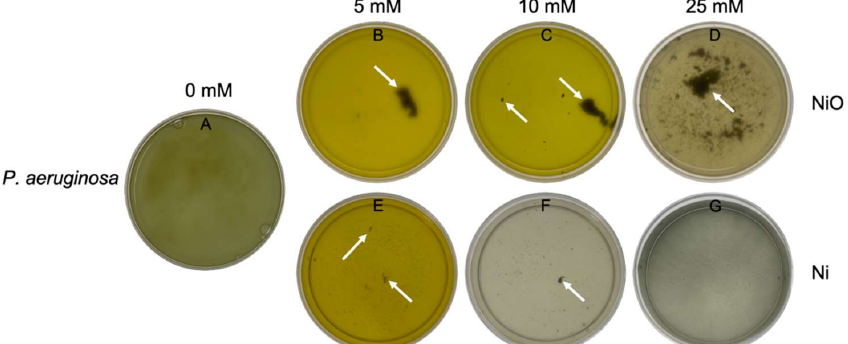
Figure 4. Morphology of the growth medium and formation of clusters. P. aeruginosa in LB medium without nanoparticles as control ( A ). P. aeruginosa was capable of filtering almost all of the NPs within a cluster at the low nickel oxide concentration ( B , C ). At the higher concentration ( D ), the accumulation was divided into several clusters. Nevertheless, most of the NPs were located within the clusters. Panels ( E , F ) also show the clustering of P. aeruginosa in Ni, but at a much smaller scale. No cluster was visible in 25 mM Ni ( G ). The images with the 50 mM concentration are not shown here because the medium was very dark due to the high concentration of NPs, making it impossible to recognize any visible features.